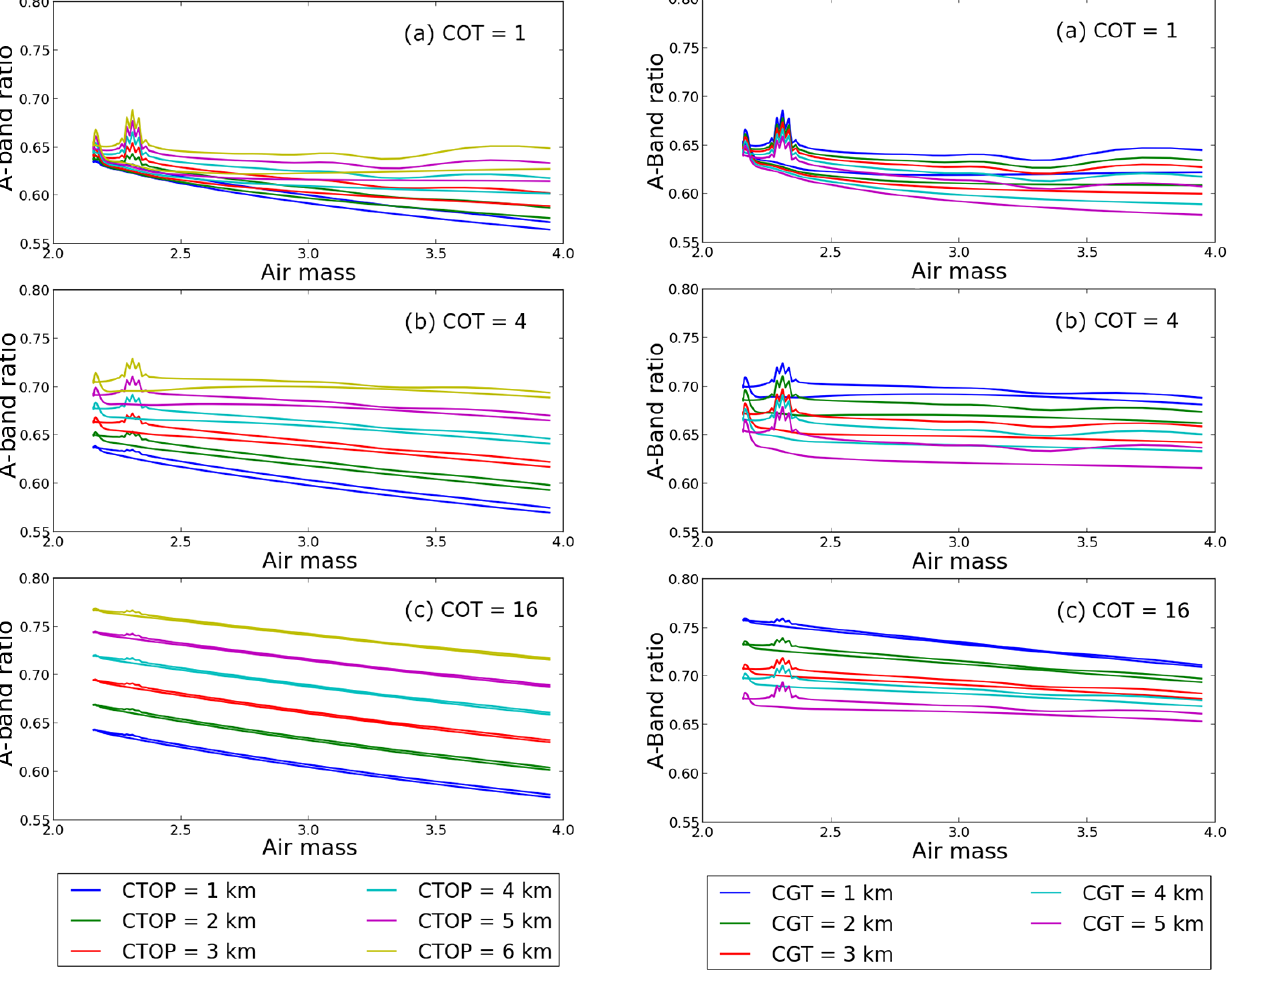
Figure 8. Same as Fig. 5 with a surface albedo of 0.2. (a) COT = 1, (b) COT = 4, (c) COT =